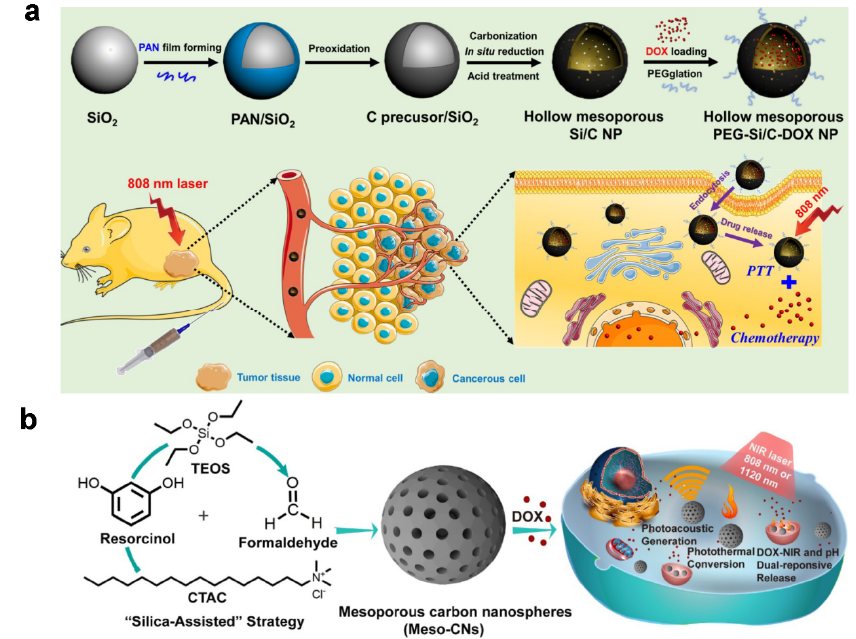
Figure 11. ( a ) Schematic illustration of fabrication of hollow mesoporous PEG-Si/C-DOX NP and its application for photoacoustic imaging-guided chemo-thermal therapy. Reproduced with permission from [96]. Copyright, Ivyspring International Publisher (2017). ( b ) Synthesis and application scheme for mesoporous carbon nanospheres (Meso-CNs) as photoacoustic agents and chemo-photothermal cancer therapy platforms. Reproduced with permission from [97]. Copyright, Ivyspring International Publisher